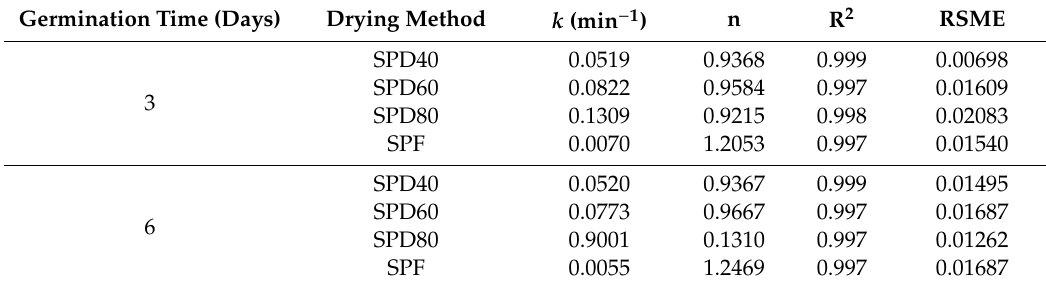
Table 1. Coe ffi cient values, R 2 and root mean square error (RSME) in the Page model describing the drying process of broccoli